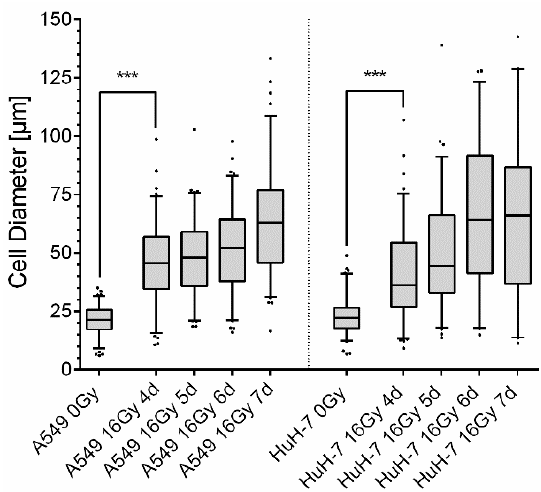
Figure 4. Increase in cell diameter after 16 Gy gamma-irradiation. After irradiation, the diameter of A549 cells (left) and HuH-7 cells (right) increased significantly until day four (4 d), followed by a slower but steady increase in cell diameter until day seven (7 d) after irradiation. Within the first four days, the cell diameter increased sharply from 20.9 µm ± 6.5 µm to 45.6 µm ± 17.6 µm in A549 cells and from 23.2 µm ± 7.9 µm to 40.5 µm ± 19.4 µm in HuH-7 cells. In the following days, the increase in cell diameter leveled off and reached values of 61.1 µm ± 23.2 µm in A549 cells and 66.3 µm ± 32.4 µm in HuH-7 cells on the seventh day after irradiation. Concomitantly, the size distribution of the cell population broadened. Shown are box blots with 5–95% percentiles and median, outliers are shown as dots, unpaired two-tailed t -test, comparison between untreated control cells and irradiated cells at the different time points, *** p < 0.001.